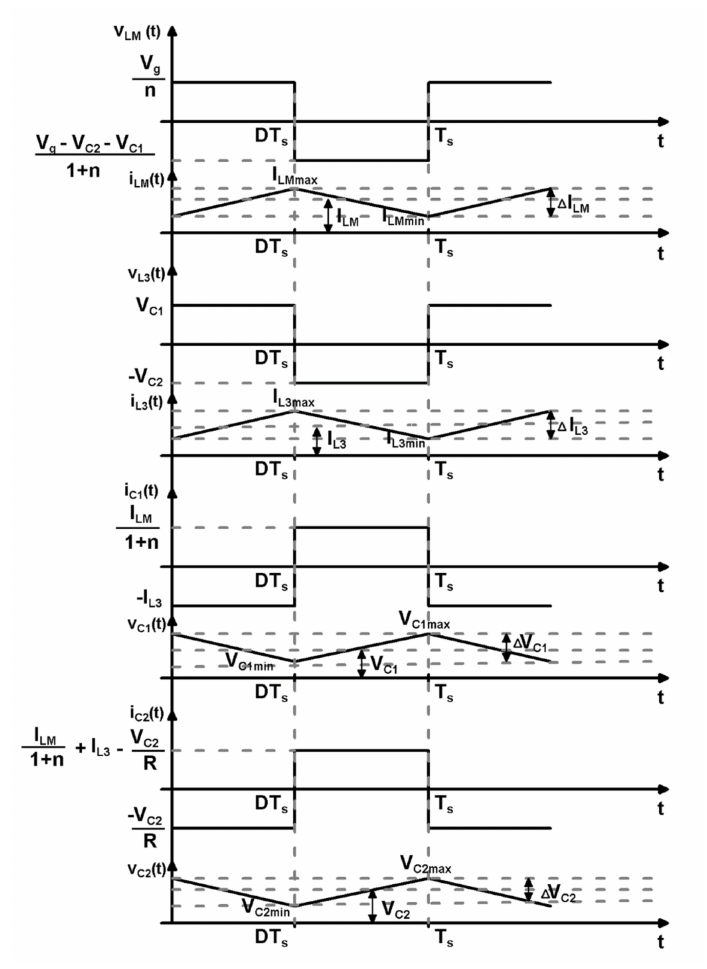
Figure 5. Main waveforms associated to the passive components of the proposed